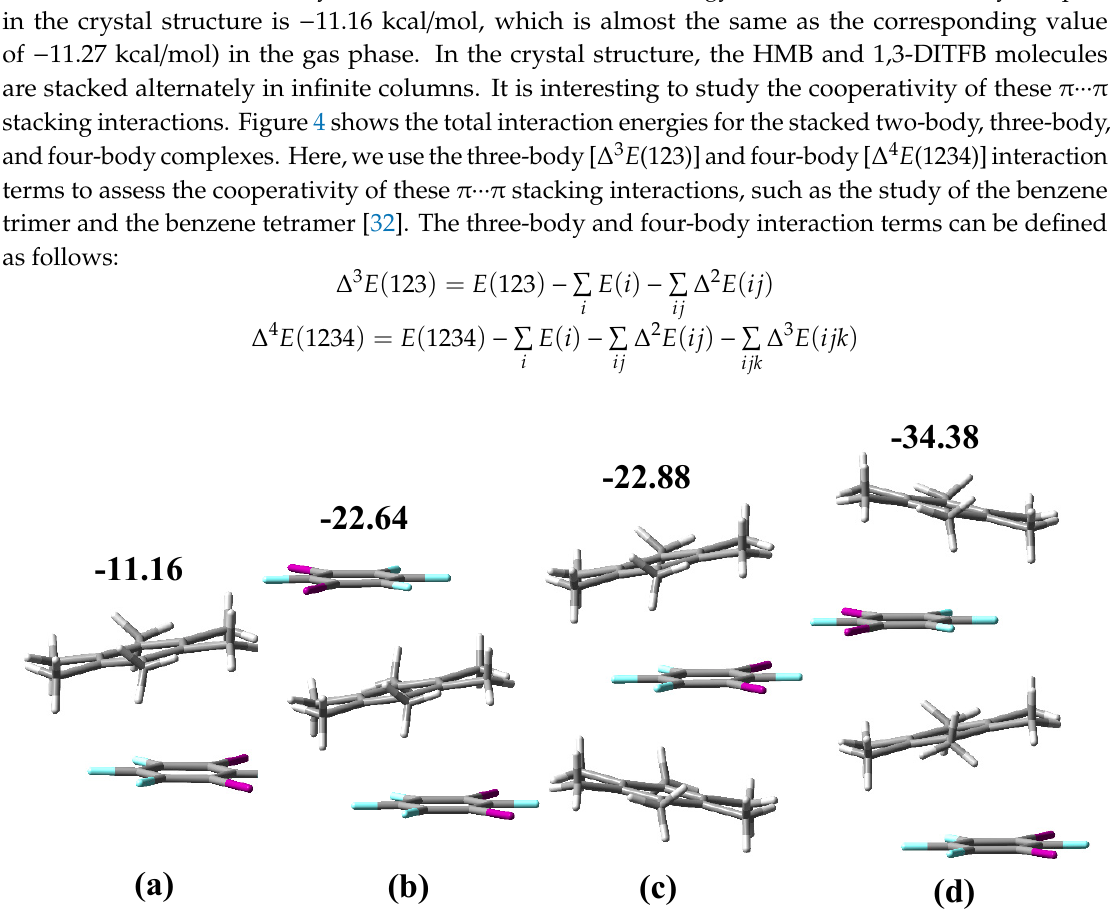
Figure 4. The interaction energies (black numbers, in kcal/mol) for the stacked two-body complex ( a ), a three-body complex ( b ), a three-body complex ( c ), and a four-body complex ( d ) with alternating HMB and 1,3-DITFB molecules.